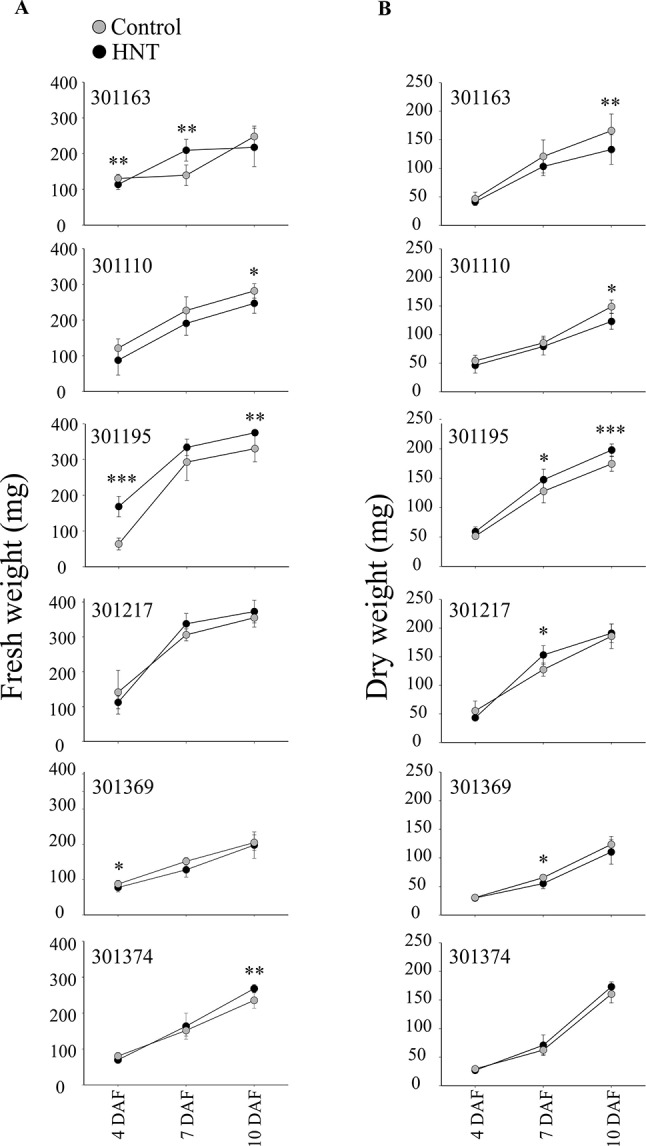
Fresh and dry weight analysis of developing seeds. Florets were marked at the time of fertilization to track the precise developmental timing. One day after fertilization (DAF), plants were either kept in control conditions or moved to greenhouse with adjusted HNT. Only the marked developing seeds at 4, 7, and 10 days after fertilization were harvested and analyzed. (A) Fresh weight was measured immediately after harvesting. (B) For dry weights, the seeds were subjected to drying for 7 days at 40 ˚C prior to measurements. For fresh and dry weight measurements (in mg), sum of ten developing seeds derived from three plants for the respective time-point and treatment was considered. Data is represented as mean ± standard deviation from three independent replicates. Student’s t-test was used for the statistical analysis (***p < 0.001, **p < 0.01, *p < 0.05). HNT, high night-time temperature.